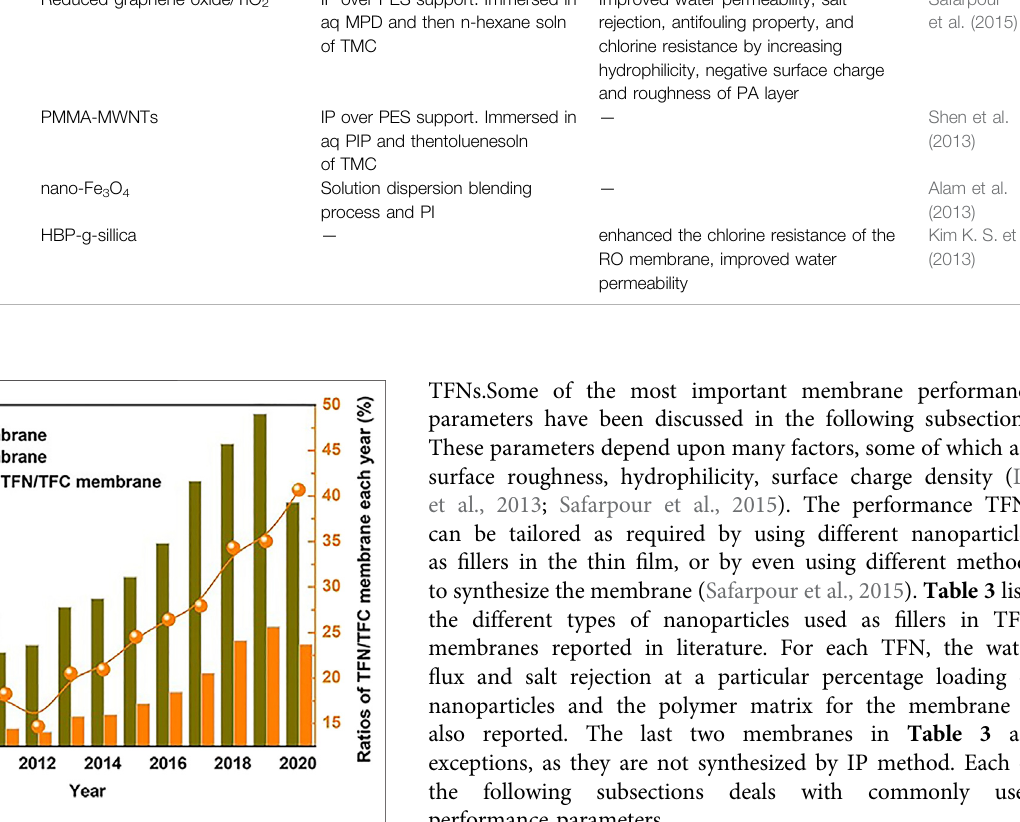
FIGURE 5 | Year wise Publication status of TFNs (Liao et al.,